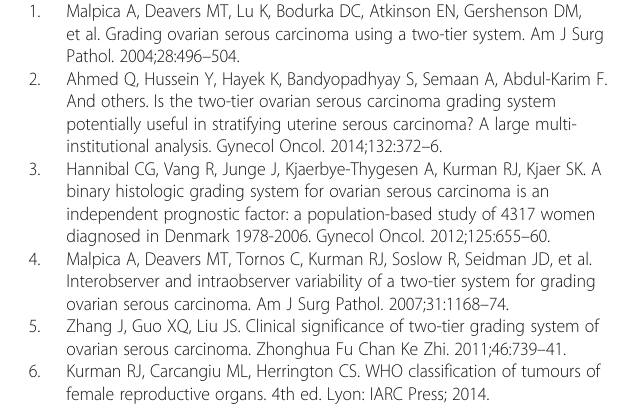
FIGO: International Federation of Gynecology and Obstetrics; HGSC: High- grade serous carcinoma; LGCS: Low-grade serous carcinoma; OS: Overall survival; SBT: Serous borderline